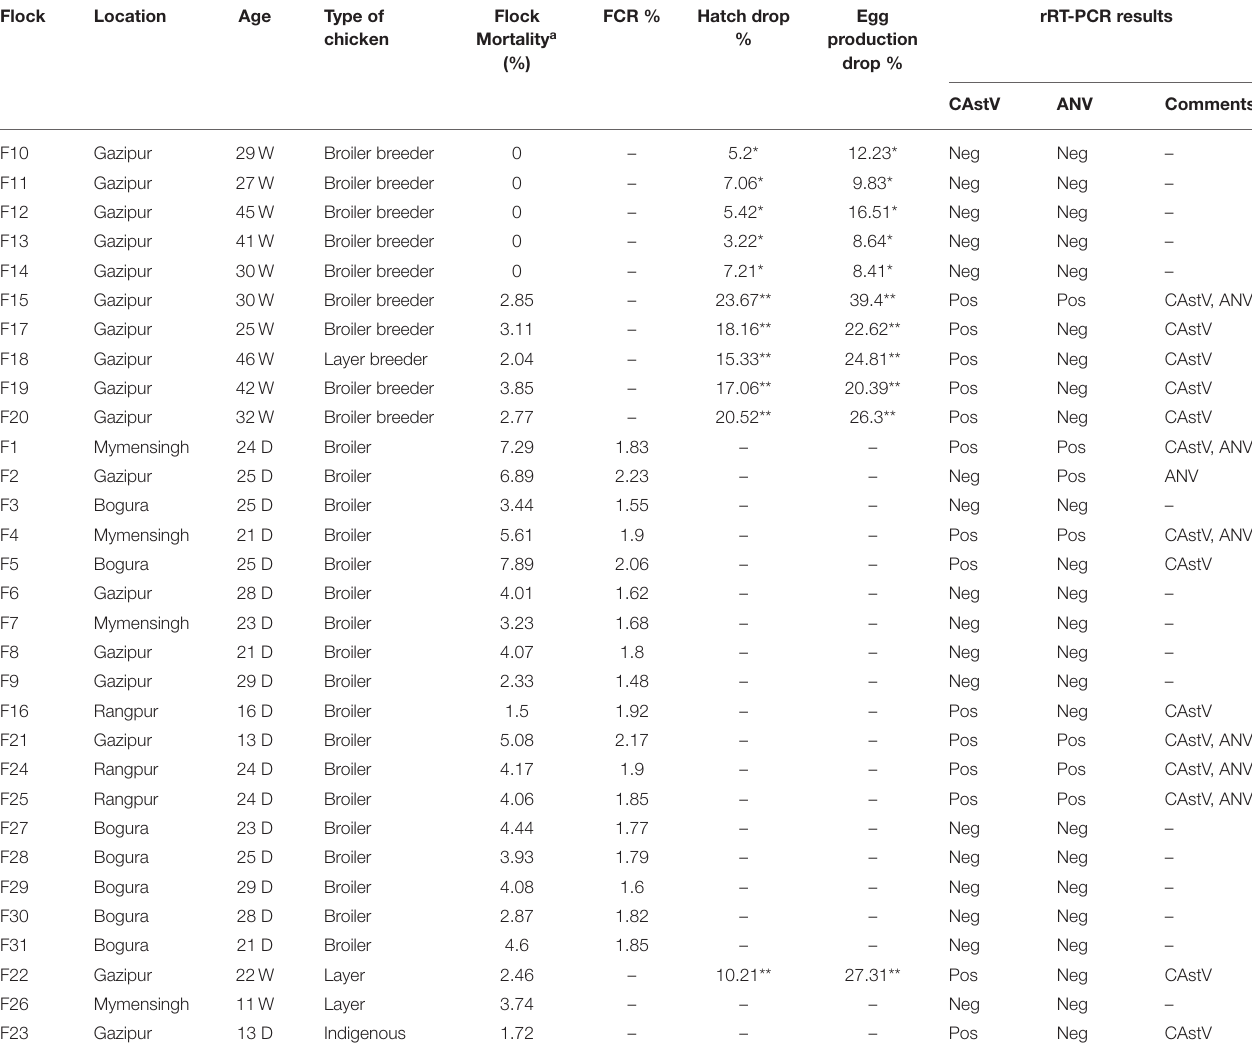
TABLE 3 | Identification of CAstV and ANV in chickens in selected areas of Bangladesh (total flock = 31). Flock